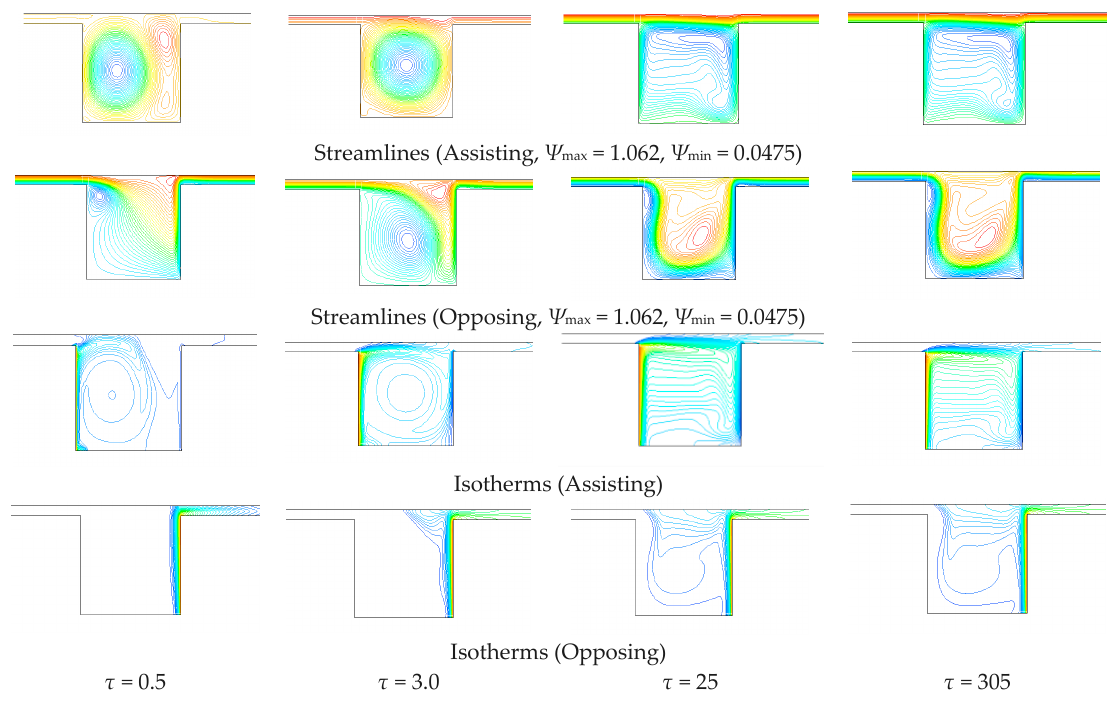
Figure 6. Streamlines and isotherms for Re = 100, aspect ratio (AR) = 1.0 and Ri = 659.00.